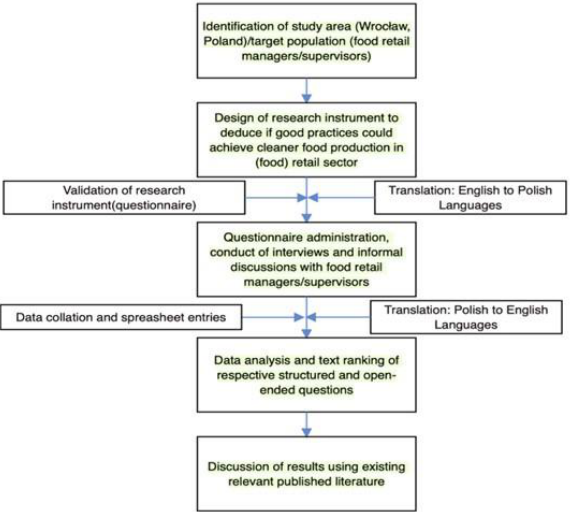
Figure 3. The schematic overview of the current preliminary survey, from the identification of the study area/target population and design of the research instrument, through to the questionnaire administration, data analysis, and discussion of results using relevant published information.